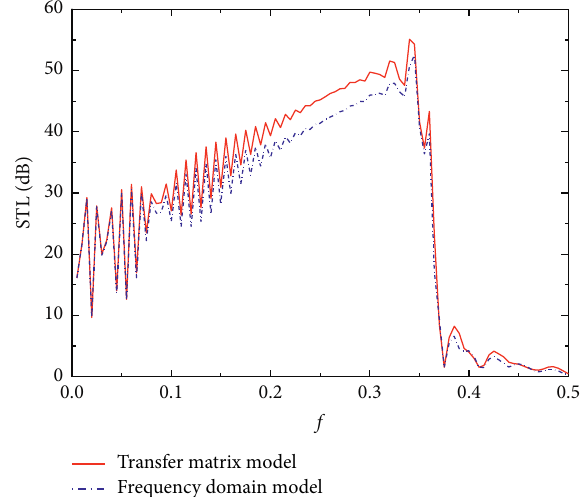
Figure 6: Variation of STL with incident sound frequency based on two different models.